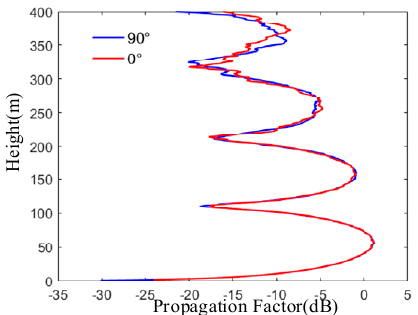
Figure 13. The propagation factor in different wind directions. The variation of propagation factor with altitude is given when the wind speed is 7 m/s and the wind direction is different.